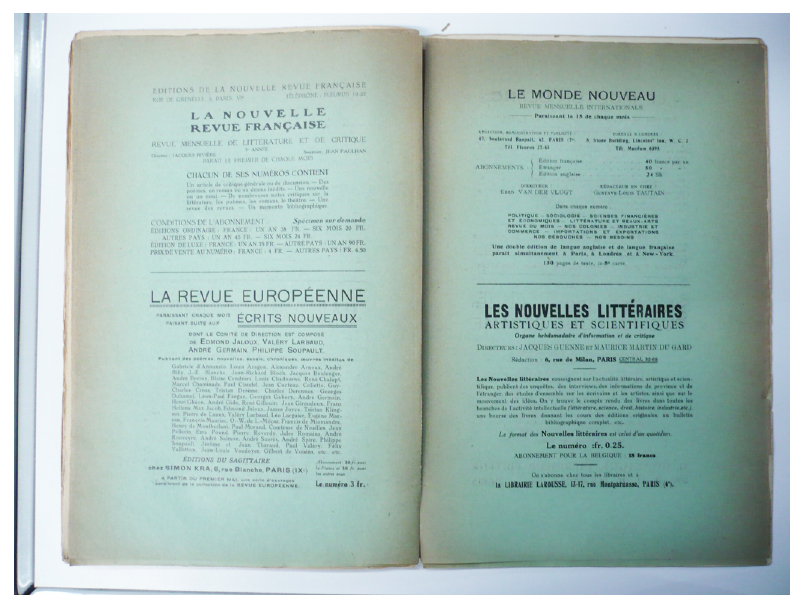
Fig. 8 Le Disque vert , no. 4–5–6 (February–March–April 1923),